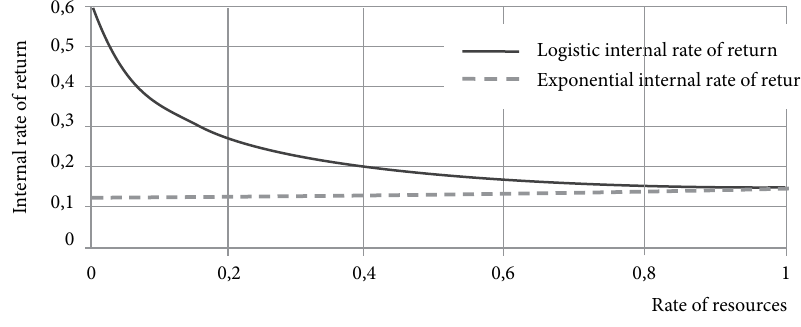
Fig. 4. Dependence of the internal rate of return on the rate of